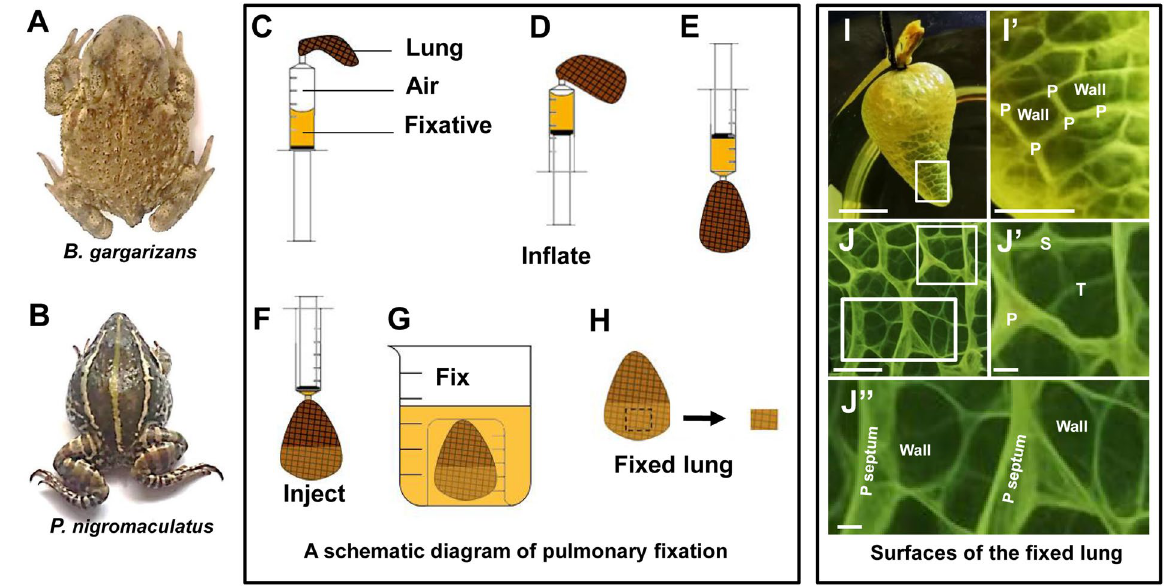
Figure 1. A schematic diagram of pulmonary fixation and the structure of inflated lung. B. gargarizans exhibits scrofulas on the dorsal skin ( A ), and P. nigromaculatus has smooth dorsal skin ( B ). Schematic diagram